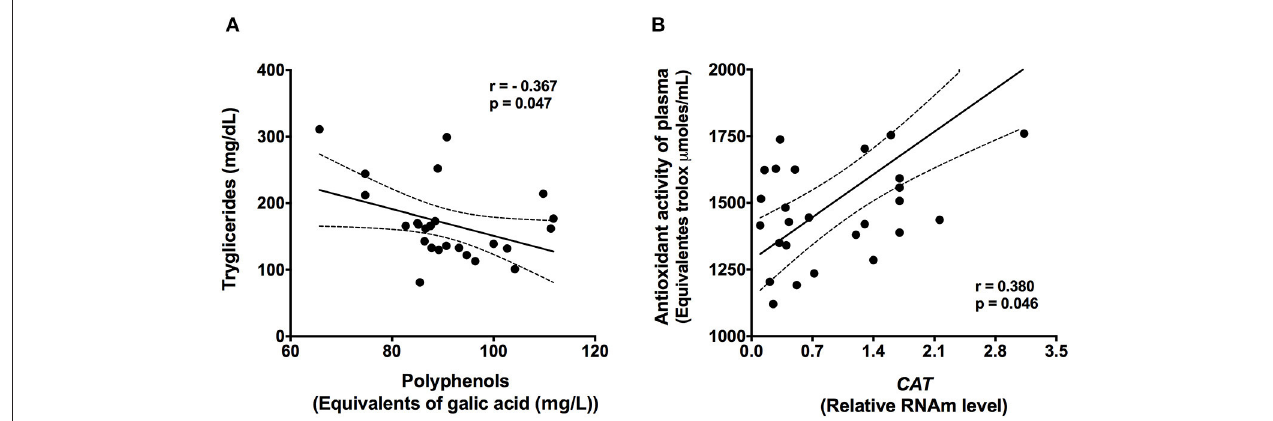
FIGURE 4 | Correlations between serum triglycerides and plasma polyphenols (A) and between plasma antioxidant activity and CAT gene expression (B) ( n = 30). Statistical analysis was performed by Spearman’s test (95% confidence interval).